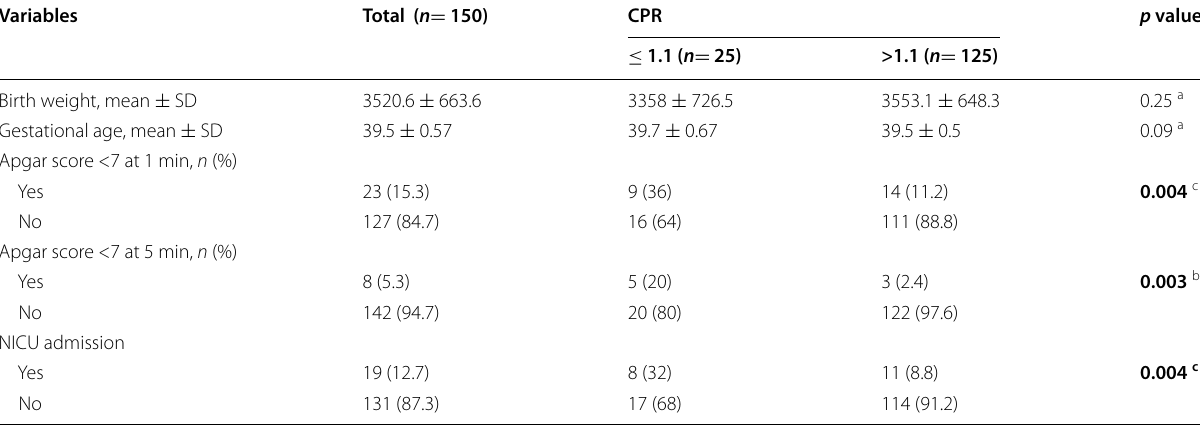
Table 3 Relationship of cerebroplacental ratio (CPR) with neonatal outcomes